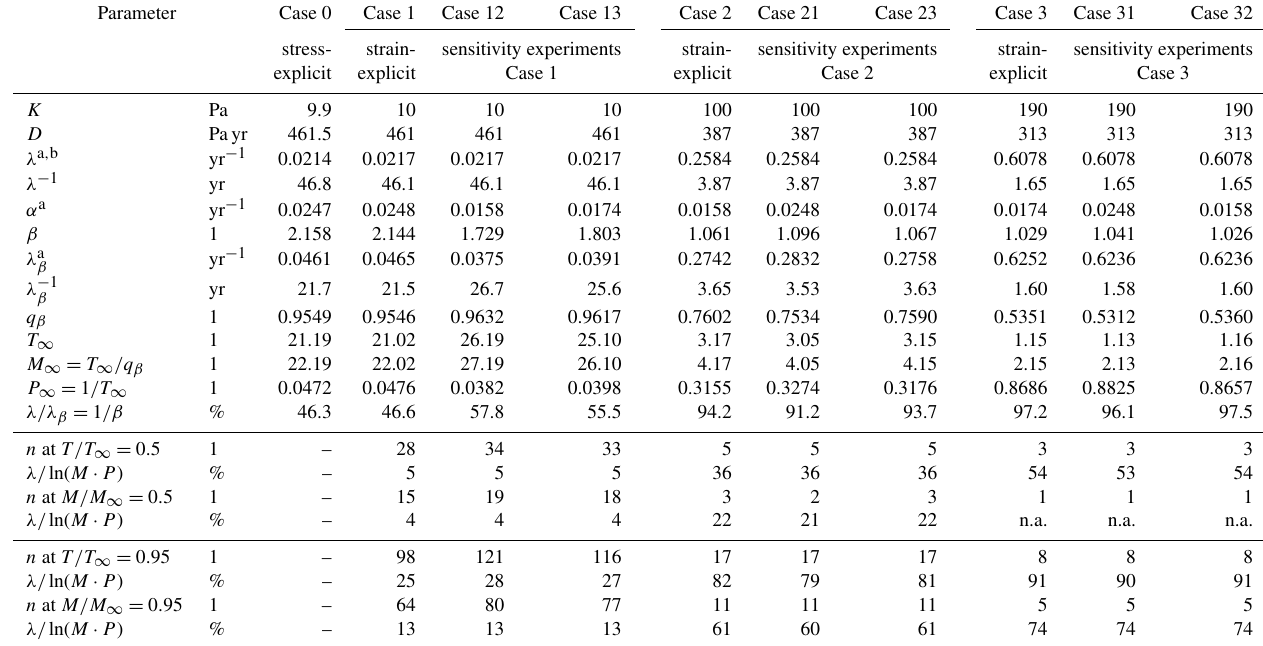
Table 1. Overview of parameters in experiments A.1–A.3. Parameter